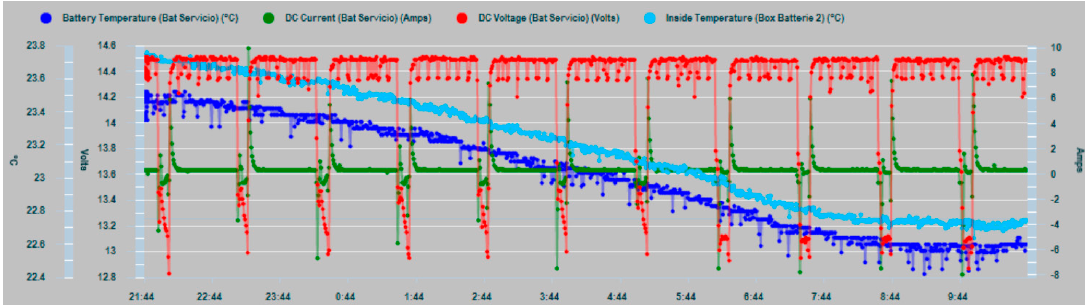
Figure 25. Zoom of ambient and battery temperature T amb and T in voltage and current over 12 h.